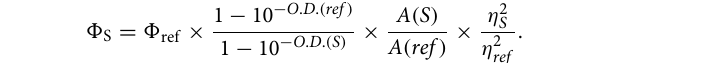
Table S7). Additionally, the relative fluorescent quantum yield (Φ) for all the components including ligand ( L ) and complexes ( C 1 and C 2 ) was determined by Eq. (3).